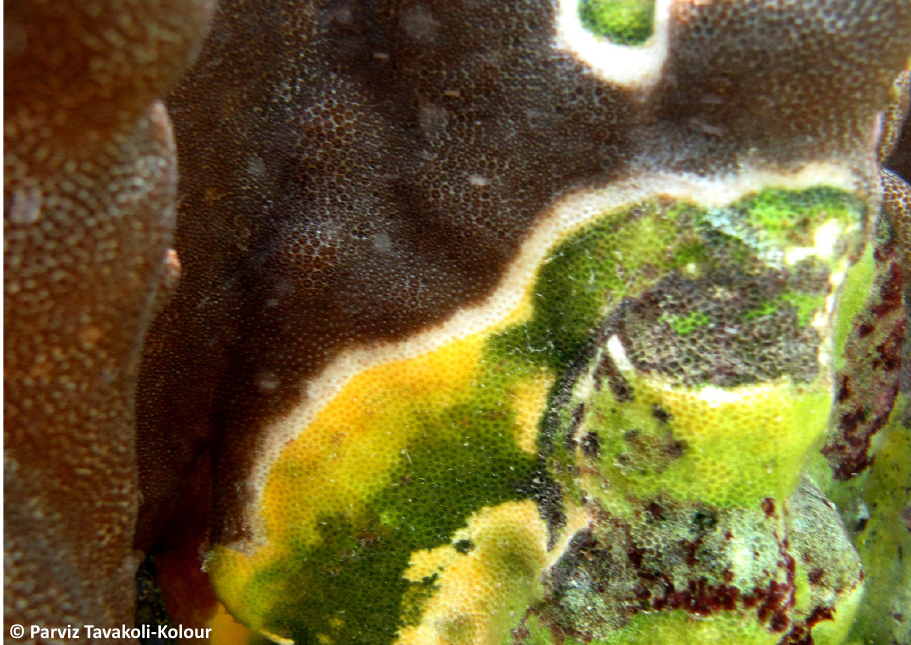
Image 2. Yellow band disease on Porites